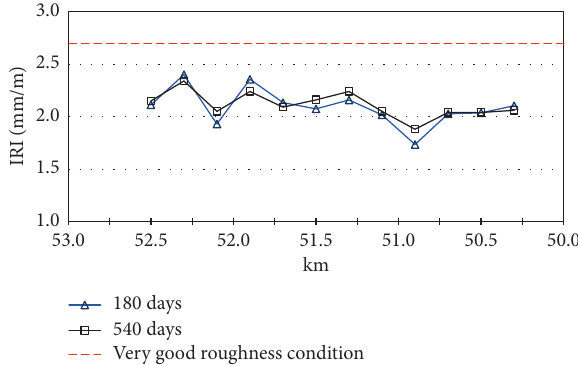
Figure 14: International Roughness Index (IRI) after 180 and 545days of the construction.